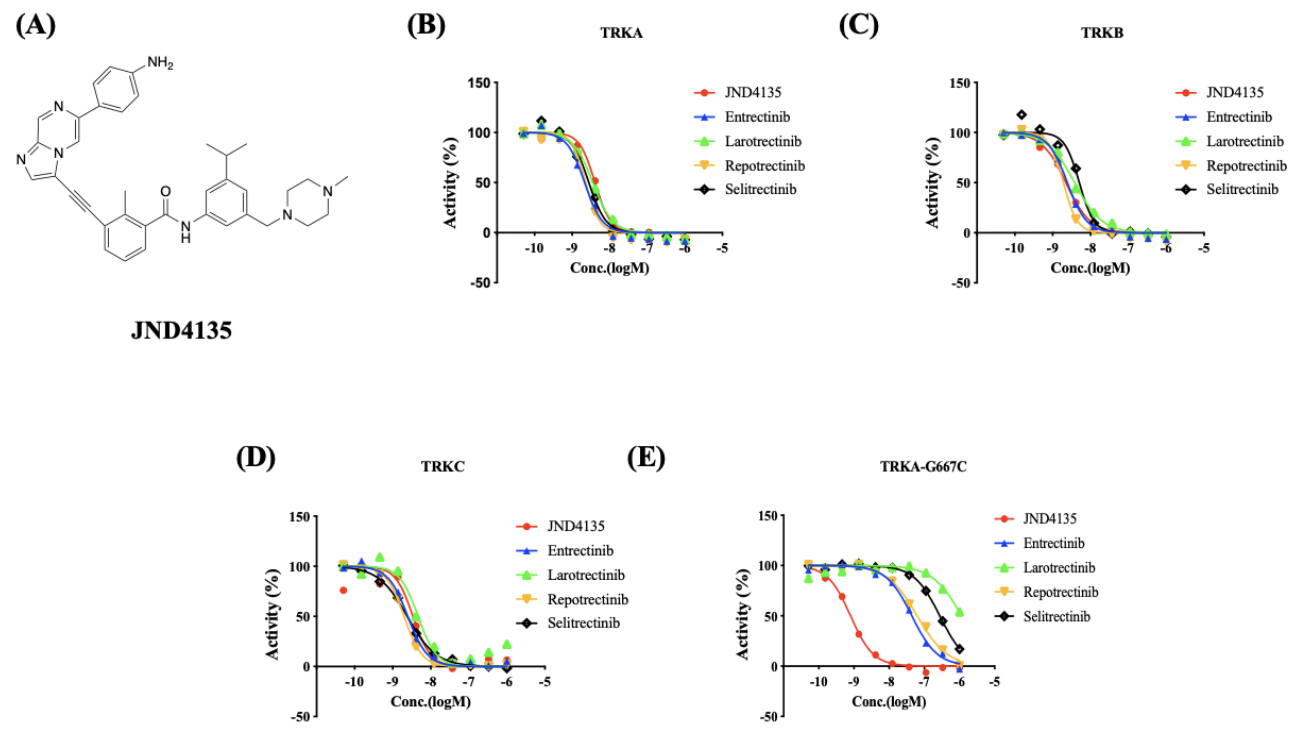
Figure 1. JND4135 displays TRK kinase inhibitory activities against both wild-type (WT) and resistant mutation. ( A ) structure of JND4135; and representative graphs of kinase inhibitory activities of JND4135 against TRKA ( B ), TRKB ( C ), TRKC ( D ) and TRKA-G667C ( E ). All kinase inhibitory assays included at least two independent experiments.